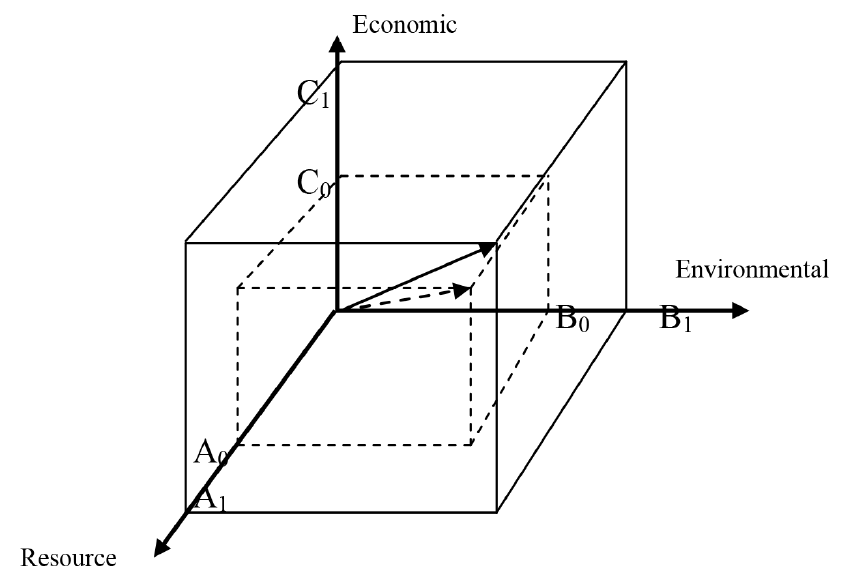
Figure 5. The total factor evaluation principle of resource value flow of product life